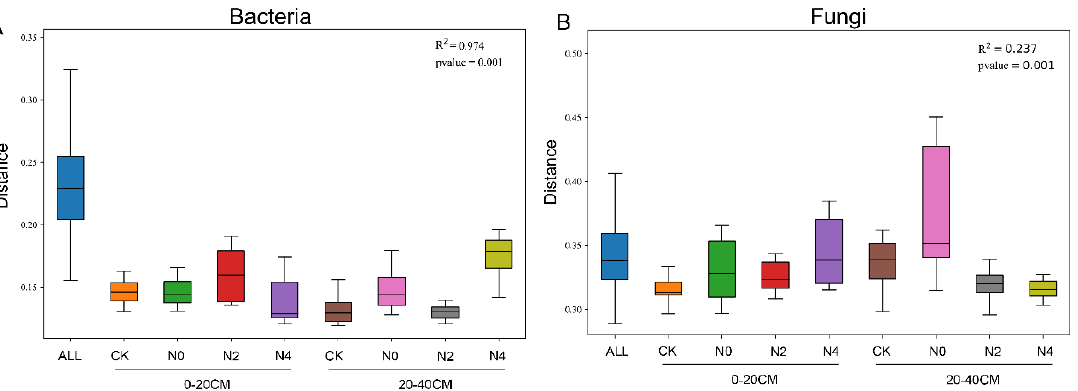
Figure 5. Analysis of variance in bacteria and fungi. The horizontal axis represents different samples. The vertical axis represents the distance. The horizontal line in the box represents the average. ( A ) Bacteria. ( B )